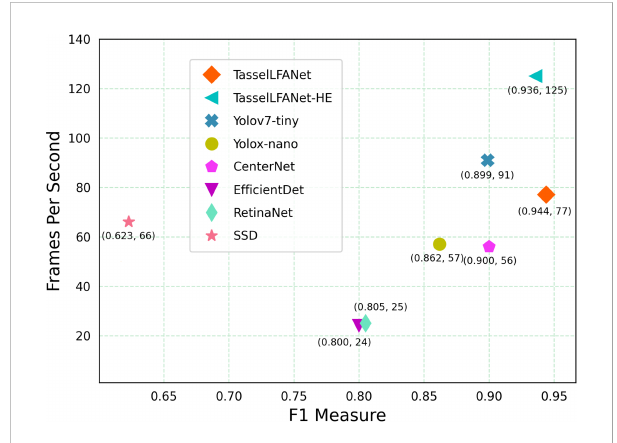
FIGURE 7 Performance and speed comparison of different